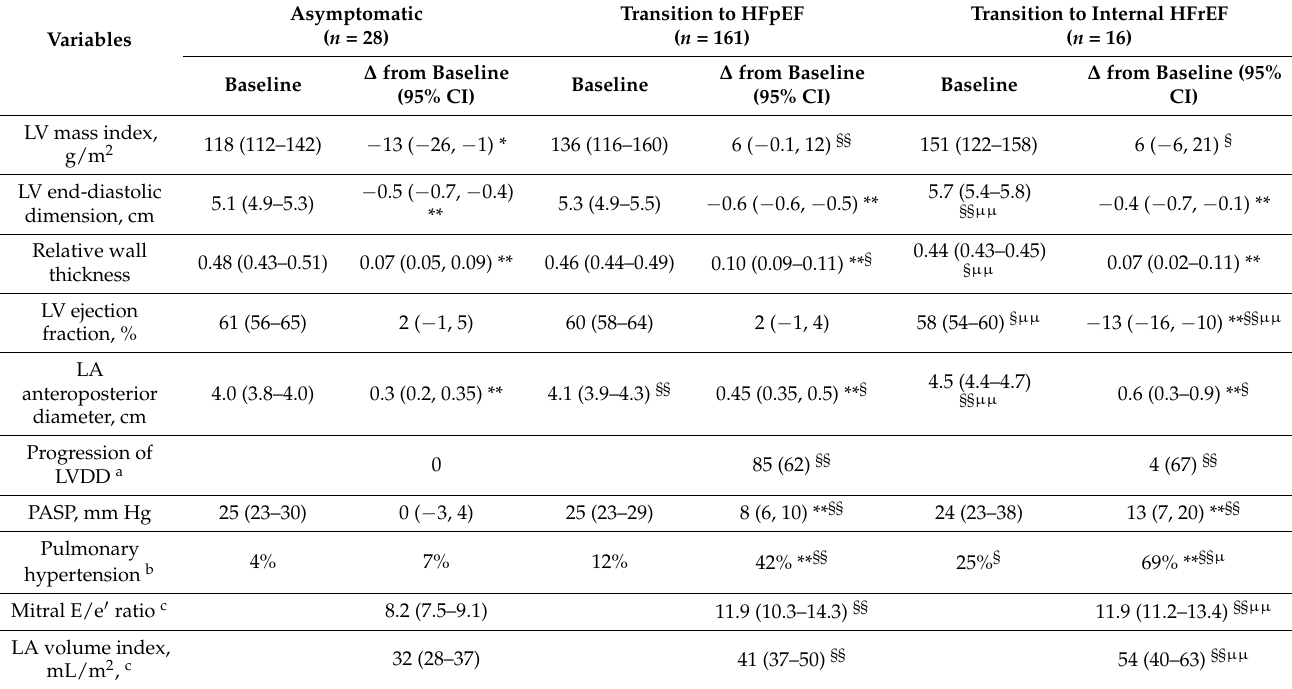
Table 3. Echocardiographic variables in new-onset HF patients vs. asymptomatic